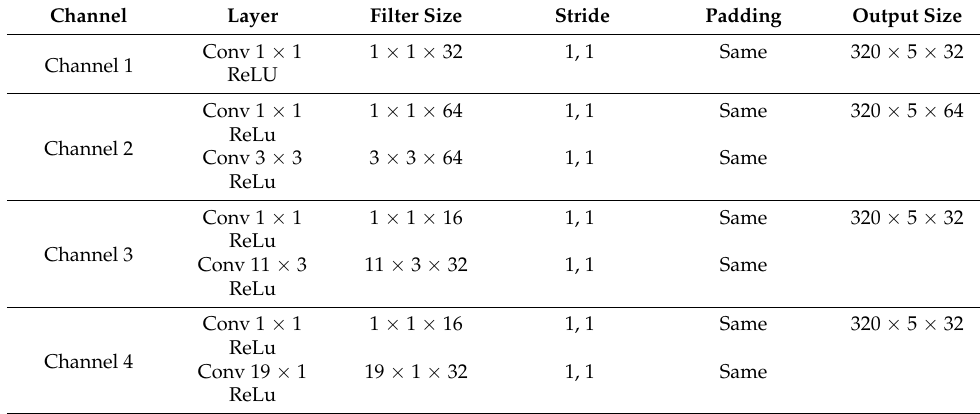
Table 3. Related parameters of designed inception module.